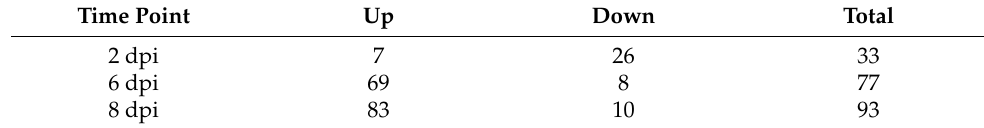
Table 2. The number of up- and downregulated differential expressed miRNAs, at 2, 6, or 8 days post infection (dpi).